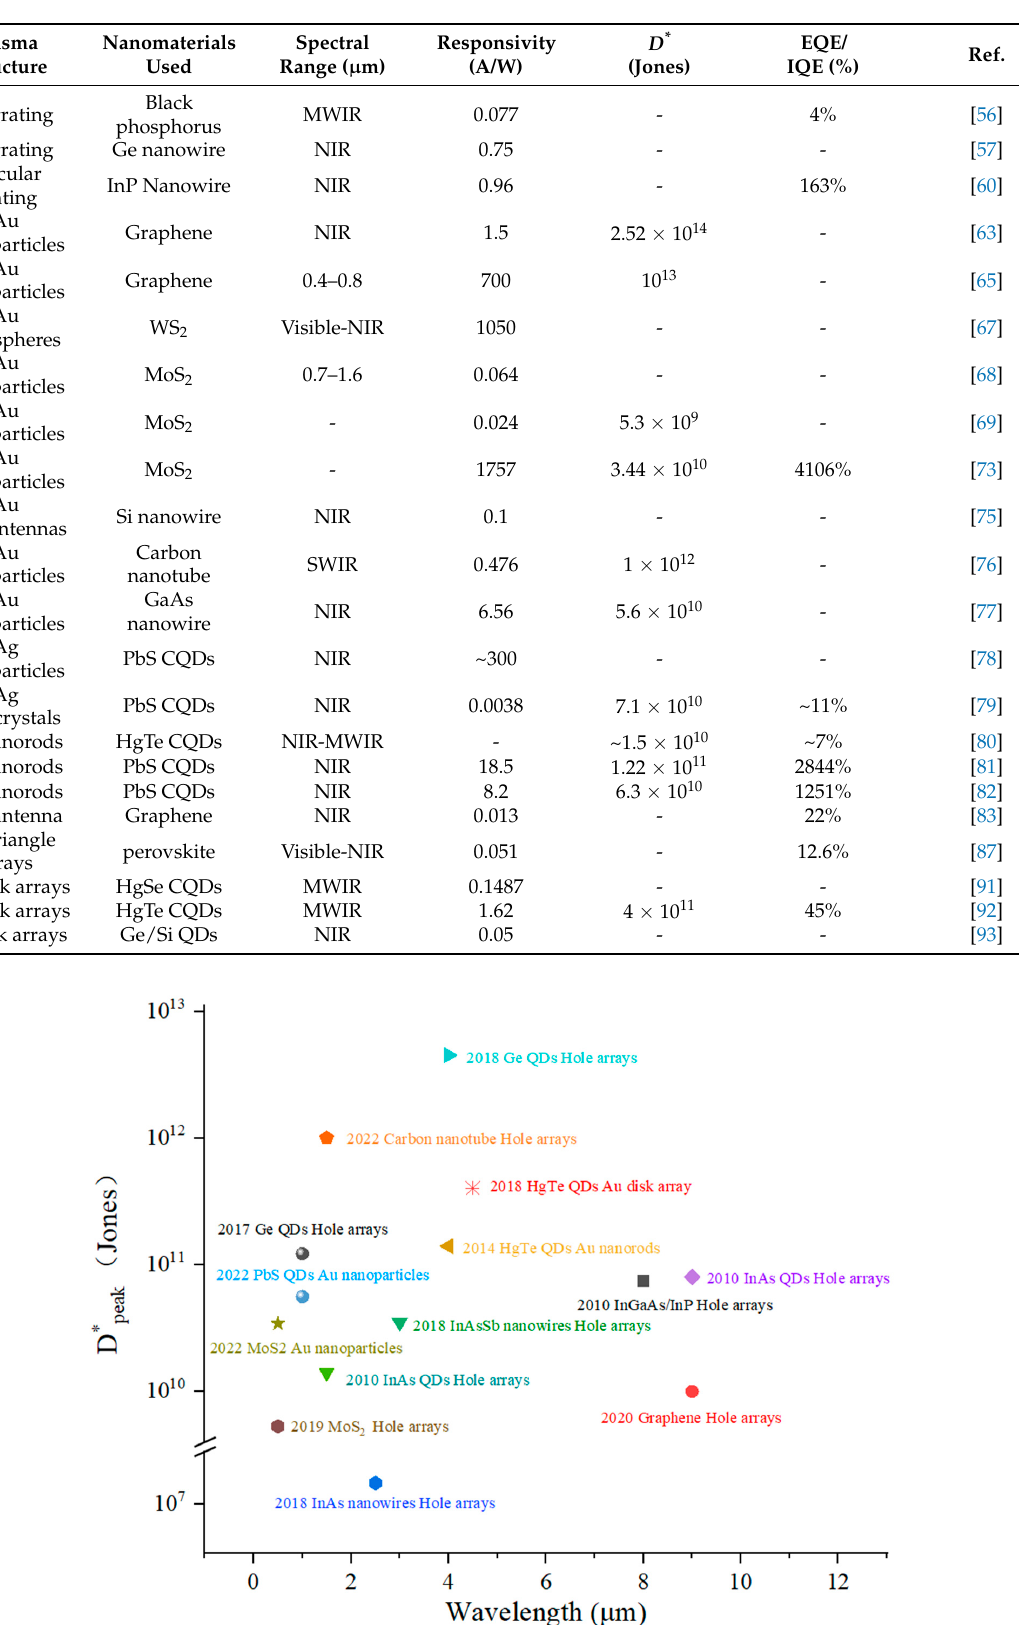
Figure 13. Peak speci fi c detectivities of some representative plasma-enhanced infrared PDs.